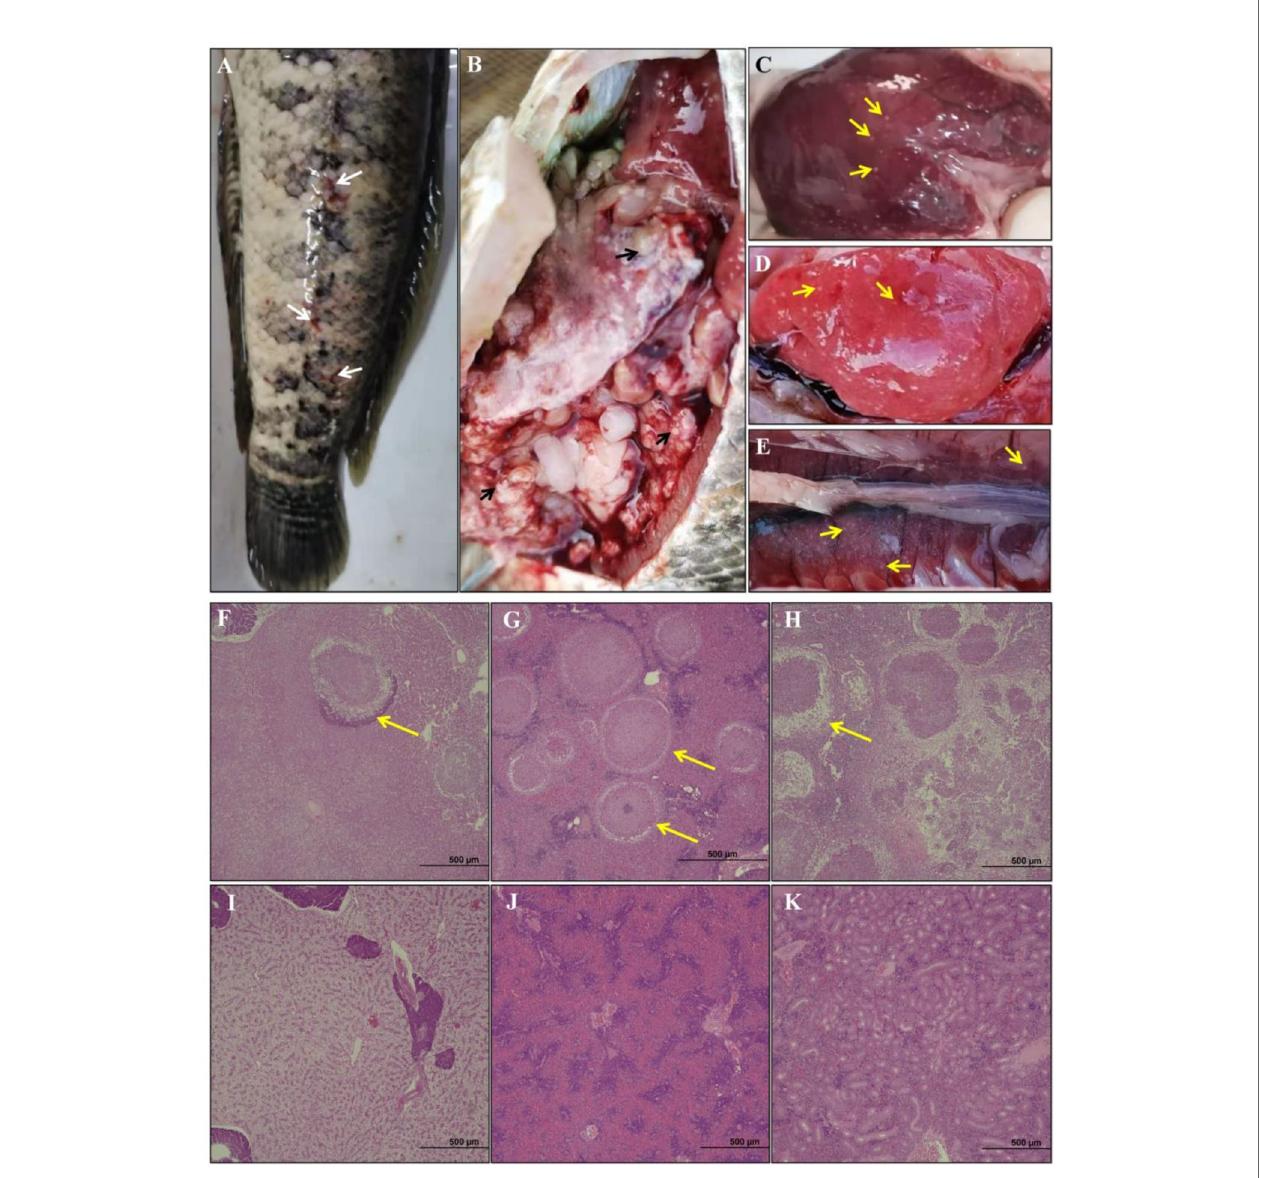
FIGURE 1 | (A) Clinical signs of diseased hybrid snakehead body surface. Appearance of abdominal cavity (B) , liver (C) , spleen (D) and kidney (E) . Histopathological sections of hybrid snakehead were shown. (F – H) correspond to the liver, spleen, and kidneys of the diseased fi sh; (I – K) correspond to the liver, spleen, and kidneys of the healthy fi sh. The white arrows indicate super fi cial lesions, black arrows indicate granules of N. seriolae , and yellow arrows indicate the necrosis and